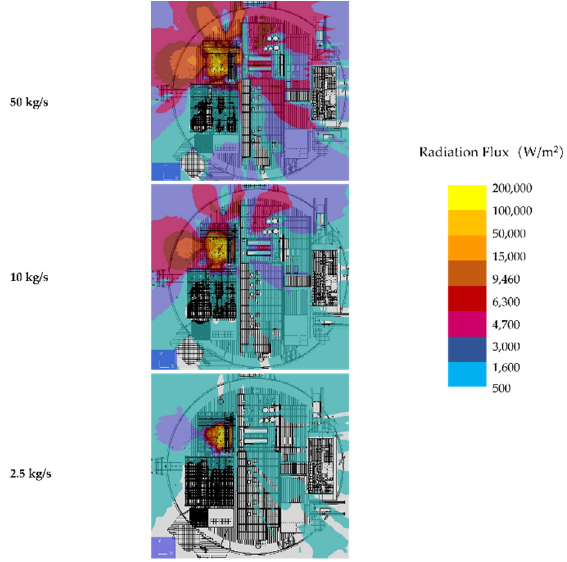
Figure 15. Leak 1 pool fire results—slice z = 50 m (process deck 2nd floor)—Radiation flux (W/m 2 ).